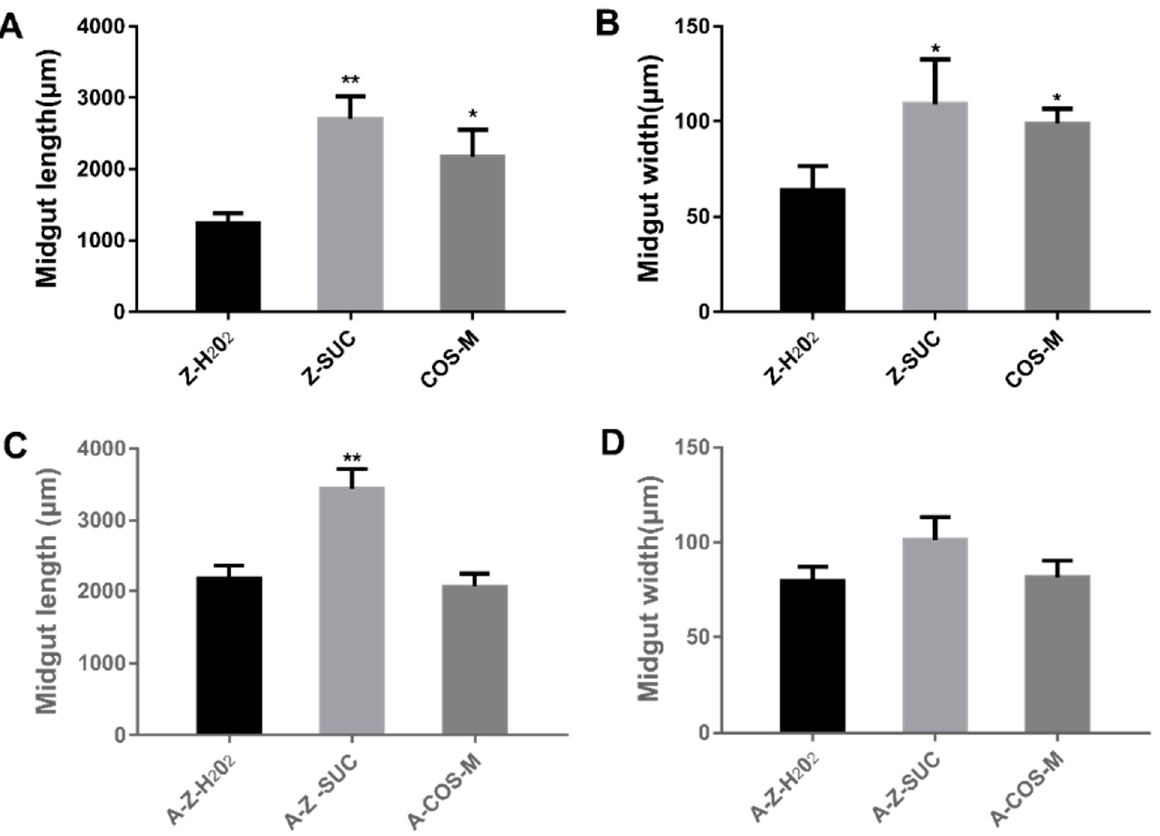
Figure 5. The length and width of guts in female fruit flies ( A , B ) and axenic fruit flies ( C , D ). Differences among treatments were obtained with one-way analysis of variance followed by Tukey’s multiple comparisons test. When compared with the H 2 O 2 treated group, * and ** represent p < 0.05 and p < 0.01 respectively.